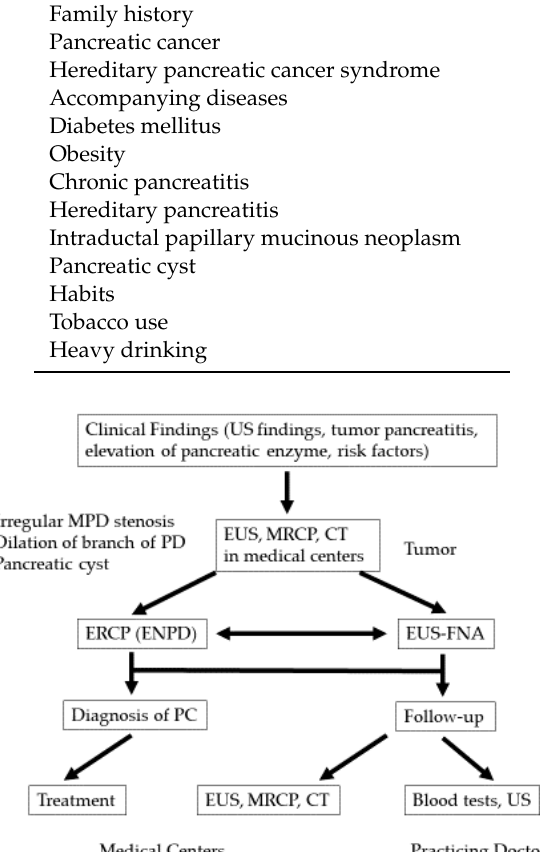
Figure 1. The algorithm for the diagnosis of pancreatic cancer (PC). CT: computed tomography, ENPD: endoscopic nasopancreatic drainage, ERCP: endoscopic retrograde cholangiopancreatography, EUS: endoscopic ultrasonography, FNA: fine-needle aspiration, MPD: main pancreatic duct, MRCP: magnetic resonance cholangiopancreatography, PD: pancreatic duct, US: ultrasonography.